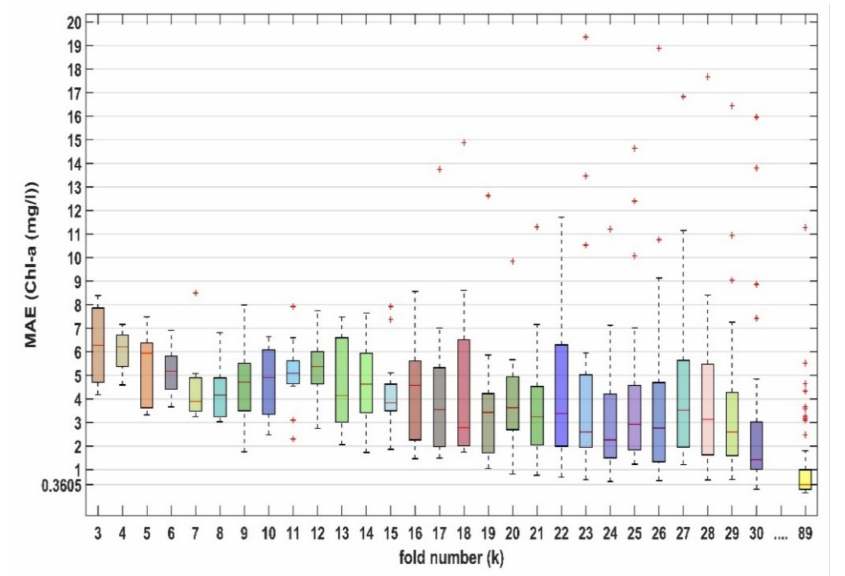
Figure 4. Comparison of the ANN’s Mean Absolute Error (MAE) performance index for k = 3:30 and k = 89 (leave-one-out case) values. k = 89 achieves the lowest MAE = 0.3605. Red marks are extreme values referred as